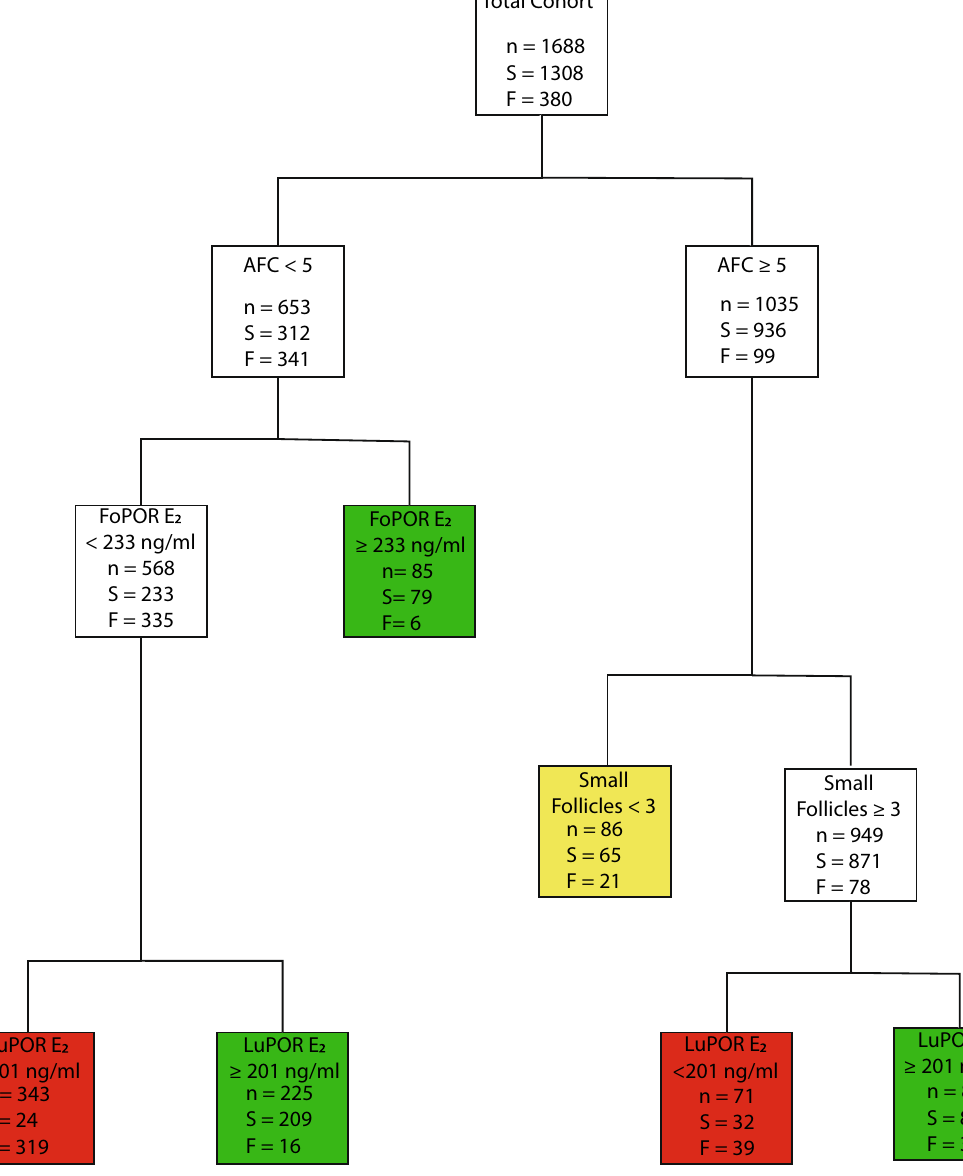
Figure 2. A clinically applicable decision-tree diagram based on the cut-off values and AUC of this model. AFC : Antral Follicle Count; FoPOR E2 : Estradiol levels evaluated on Follicular Phase Oocyte Retrieval trigger day; Small Follicles : Number of follicles withdiameter less than 13mm recorded on FoPOR; LuPOR E2 : Estradiol levels evaluated on Luteal Phase Oocyte Retrieval trigger day; n : Number of observations; S : LuPOR success, defined as the retrieval of at least one MII oocyte; F : LuPOR failure, defined as failure to retrieve an MII oocyte. The decision tree is hierarchized according to the timing of each observation. For a node to split, each parent node should consist of at least 100 observations andeach child node should include at least 50 observations. If the parent node consisted of more than 100 observation, but one of the child included less than 50observations, the splitting was performed at the next observed parameter. Terminal nodes are colored. Green color represents good prognosis regarding LuPORsuccess; Yellow color represents LuPOR success, albeit with lower probabilities compared to the total cohort. Red color represents poor prognosis regardingLuPOR